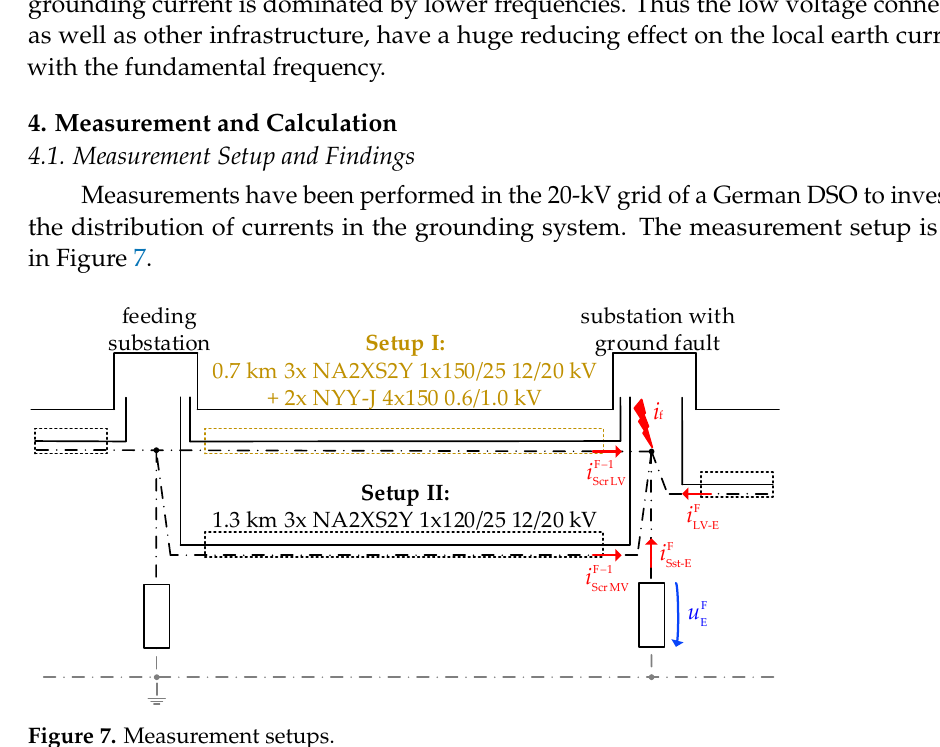
Figure 7. Measurement